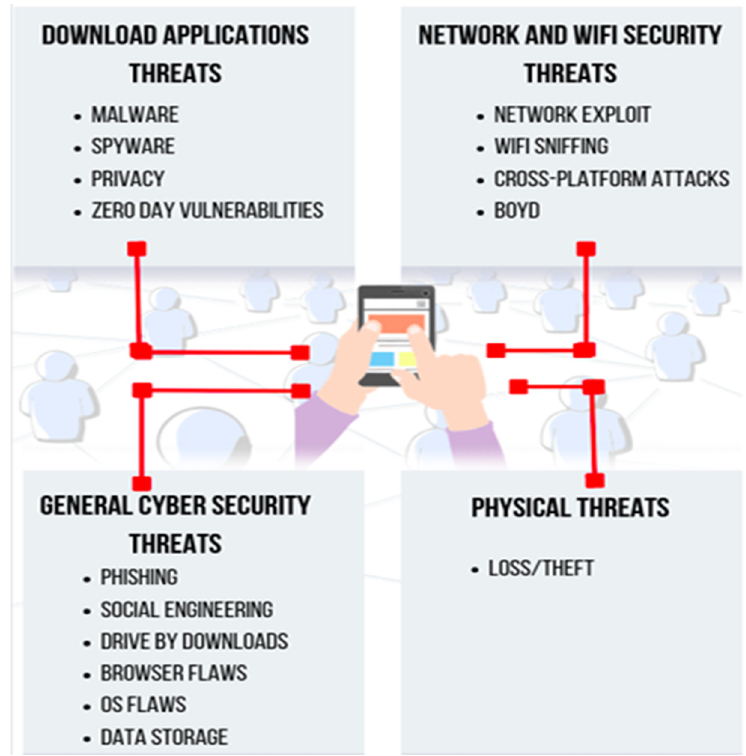
Figure 9. General taxonomy of cyber-threats. Table 4. List of various cyber-attack datasets.